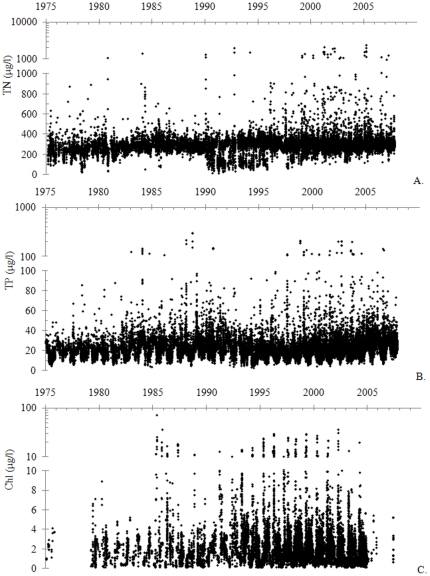
Trophic state indicators in surface waters of the Baltic Sea, 1975–2007.Concentrations in individual samples taken during the whole year. A. Total nitrogen (TN) concentrations; data from [18]. B. Total phosphorus (TP) concentrations; data from [18]. C. Chlorophyll-a (Chl) concentrations; data from [3]. The upper part of the y-axis scales are logarithmic in order to enable representation of the highest values.